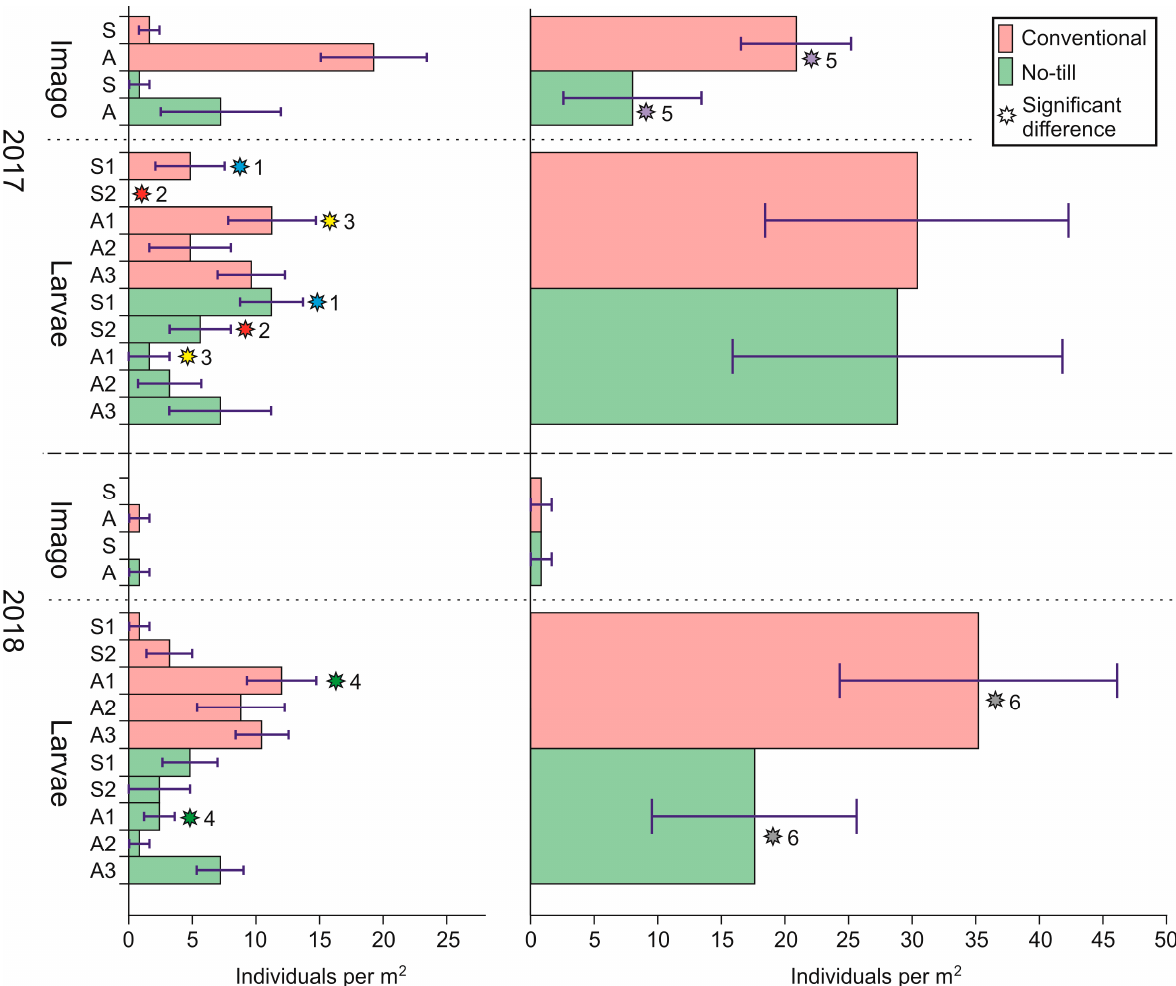
Figure 4. Density distribution of adults and larvae of click beetles (Coleoptera, Elateridae) in CT and NT plots. ( Left ): by species (S1, Selatosomus aeneus ; S2, Selatosomus latus ; A1, Agriotes sputator ; A2, Agriotes lineatus ; A3, Agriotes obscurus ). ( Right ): overall density of Elateridae. Standard error is shown by whiskers. Stars of one color with same figures show the significant difference between certain parameters. Table 4. General indicators of species diversity of ground beetle communities (Coleoptera,